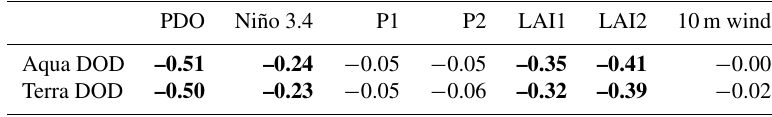
Table 1. Correlations between monthly DOD indices and the PDO, Niño 3.4 indices, precipitation from the CRU TS3.23 (P1; 2003–2014) and PRECL (P2), AVHRR LAI (LAI1), MODIS Aqua LAI (LAI2) and 10m wind speed from the ERA-Interim averaged over Syria (see the box in Fig. 2) for all the months (seasonal cycles are removed) from 2003 to 2015 (or 2014). Coefficients significant at the 95% confidence level are in bold.